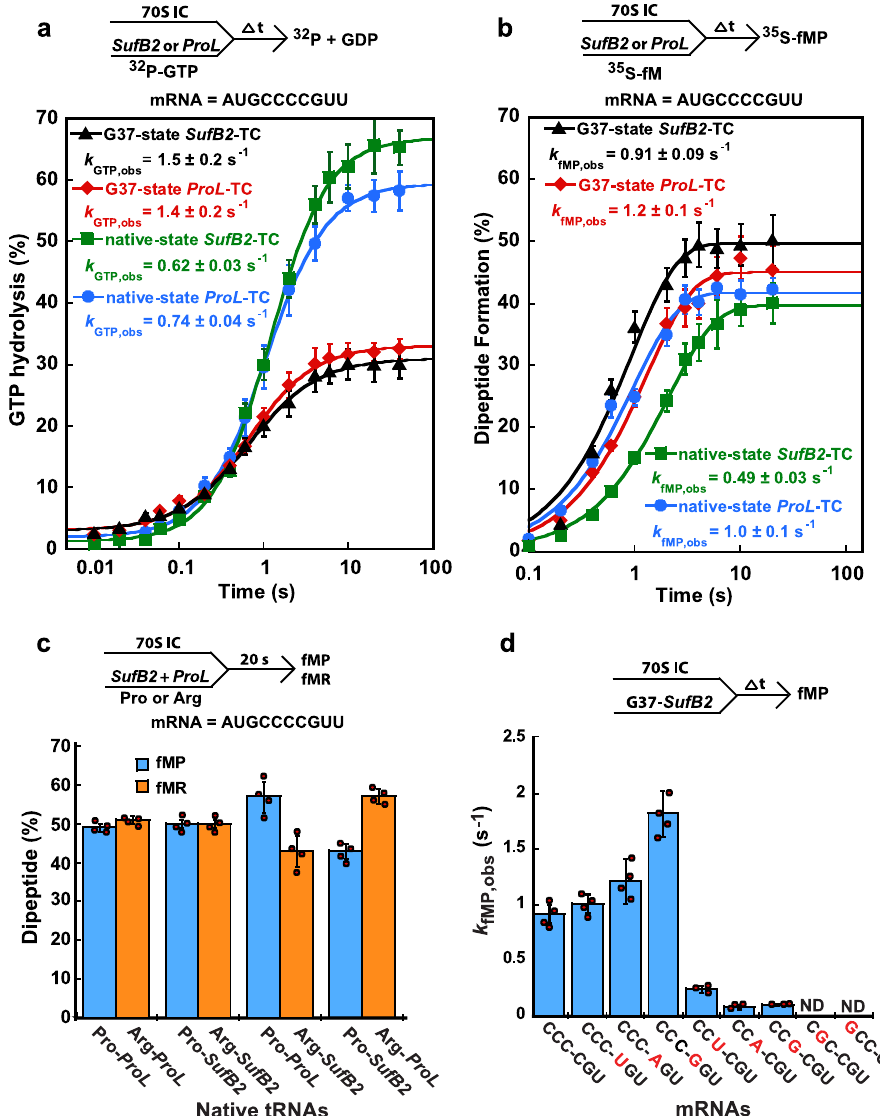
Fig. 3 SufB2 uses a triplet anticodon-codon pairing scheme at the A site. a GTP hydrolysis by EF-Tu as a function of time for delivery of G37- or native- state SufB2 - or ProL -TC to the A site of a 70S IC. Although the concentration of TCs was limiting, which would limit the rate of binding of TCs to the 70S IC, the observed differences in the yield of GTPase activity indicated that binding was not the sole determinant, but that other factors, such as the identity and the methylation state of the tRNA, affected the GTPase activity. b Dipeptide fMP formation as a function of time for delivery of G37- or native-state SufB2 - or ProL -TC to the A site of a 70S IC. Due to the limiting concentration of the 70S IC, which did not include the tRNA substrate, the yield of di- or tri-peptide formation assays was constant even with different tRNAs in TCs. c The yield of fMP and fMR in dipeptide formation assays in which equimolar mixtures of native-state SufB2 -TC, carrying Pro and/or Arg, and/or native-state ProL -TC, carrying Pro and/or Arg, are delivered to 70S ICs. The mRNA in 70S ICs in (A – C) is AUG-CCC-CGU-U. d Dipeptide formation rate k fMP,obs for delivery of G37-state SufB2 -TC to 70S ICs containing sequence variants of the CCC-C motif in the A site. In a , b the bars in the graphs are SD of 3 independent ( n = 3) experiments, in c the bars in the graphs are SD of 4 independent ( n = 4) experiments, and in d the bars in the graphs are SD of 3 or 4 independent ( n = 3 or 4) experiments. All data are presented as mean values ± SD. Δ t: a time interval, ND: not